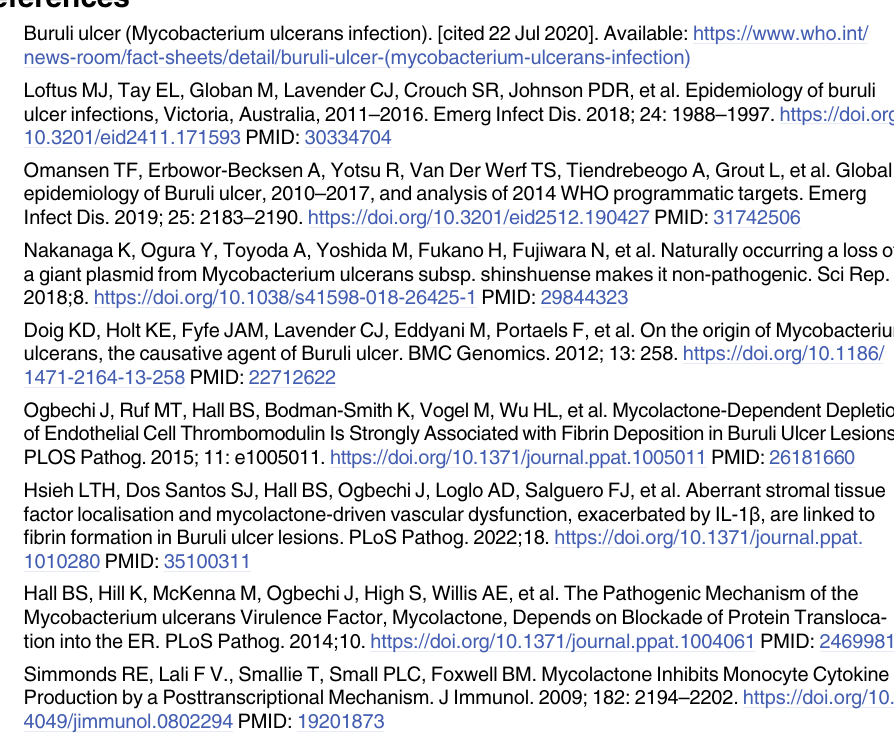
S1 Table. Thickness of hind footpads in M . ulcerans infected mice treated with or without RLZ. Average of thickness of hind footpads (mean ± SD, x10 -2 mm). Parentheses indicate